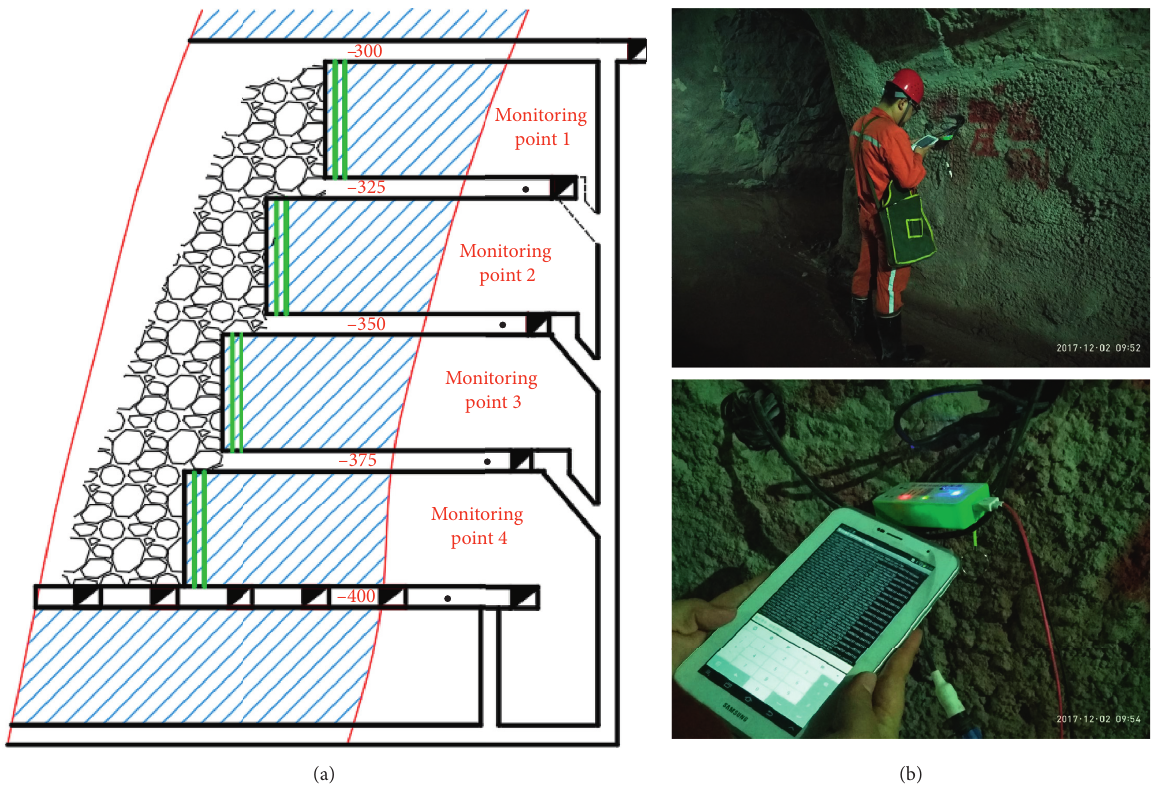
Figure 3: 16-2 # stope monitoring point layout and data